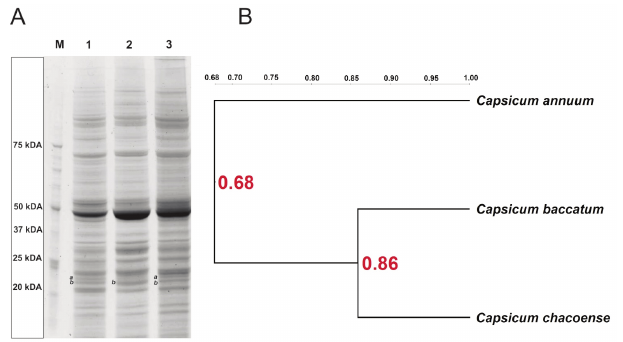
Fig. 4 ­ (A) SDS­PAGE analysis of proteins getting from Capsicum samples, where 1= C. chacoense ; 2= C. annuum ; 3= C. baccatum ; M= molecular marker. (B) Phylogenetic tree resulting from the analysis of protein by SDS­PAGE analy­ sis. Image data were processed with Quantity One software (Bio­Rad Laboratories, Inc, Hercules CA) using Ward's method for clustering (Ward,